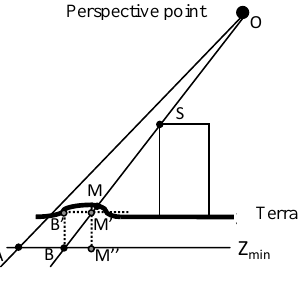
Figure 3. The buildings occlude the